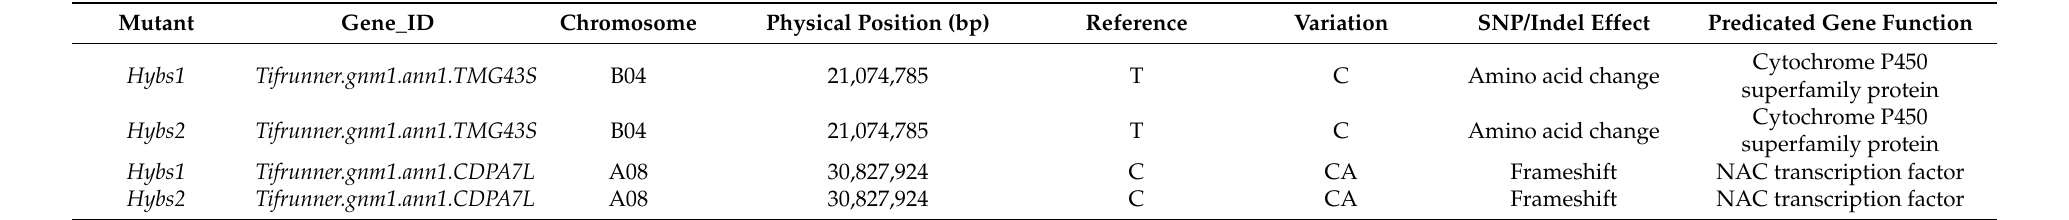
Table 3. Summary of identified candidate genes related to the seed size phenotype based on RNA-seq and